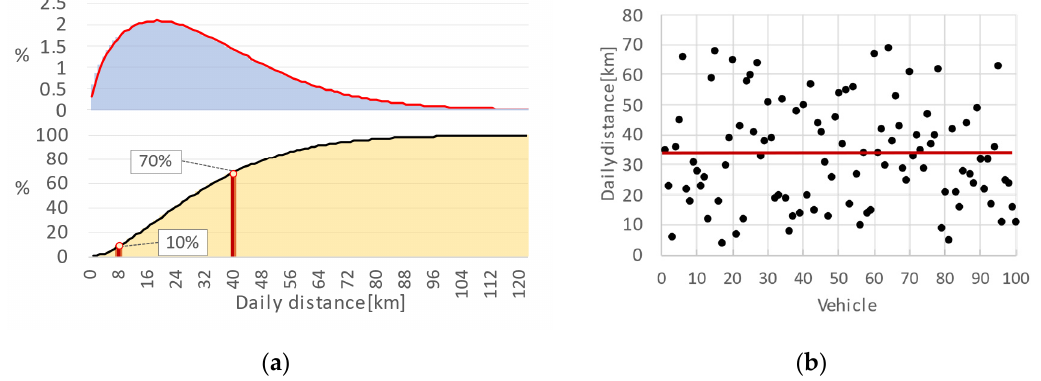
Figure 5. Probabilistic distribution of the daily traveled distance: ( a ) the top plot is the Weibull distribution, and the bottom plot is its cumulated function; and ( b ) the daily distances traveled by each vehicle belonging to a car fleet of 100 elements and their average ( red line ).